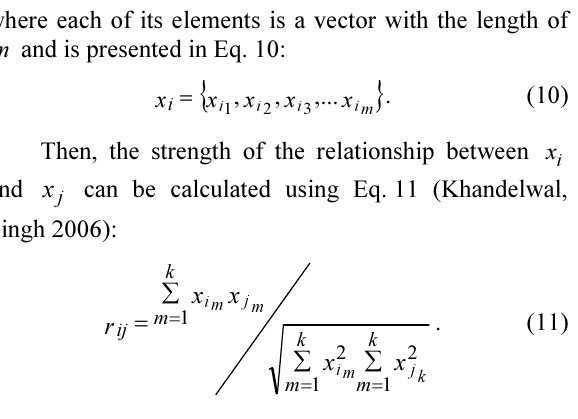
Fig. 3. Schematic architecture of the optimal network